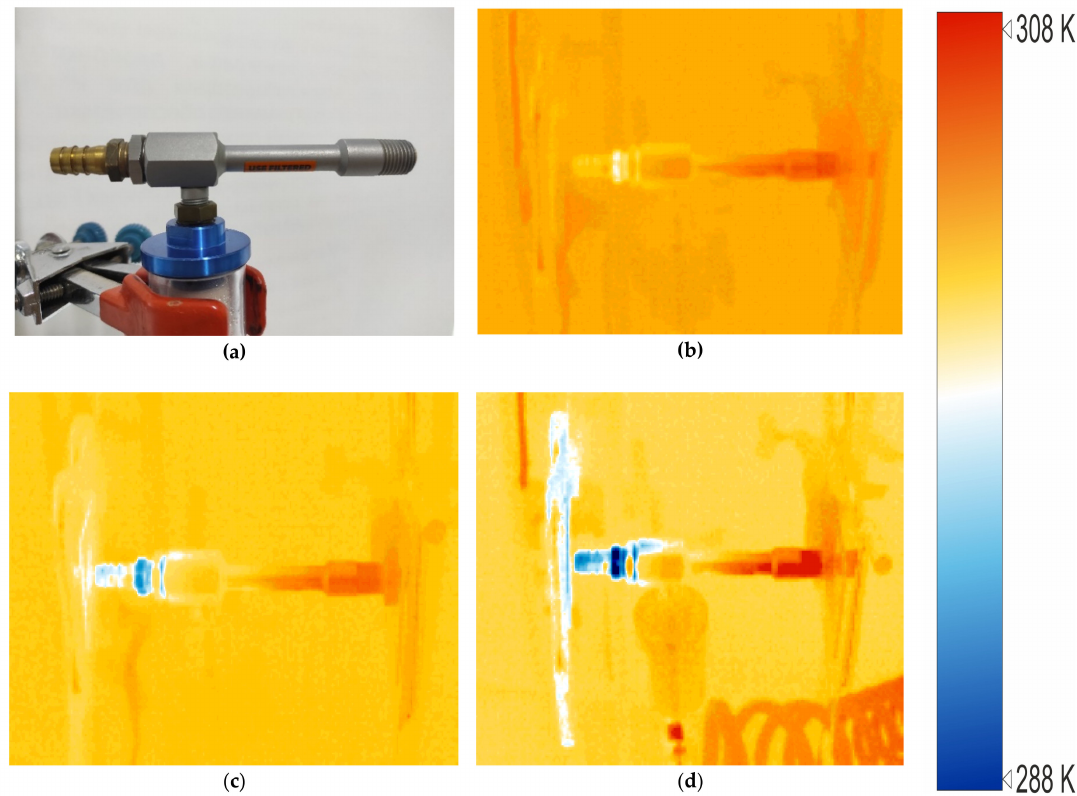
Figure 2. ( a ) NexFlow 50002H vortex tube; thermogram of the vortex tube; ( b ) inlet gas pressure is 1 bar; ( c ) inlet gas pressure is 2 bar; ( d ) inlet gas pressure is 3